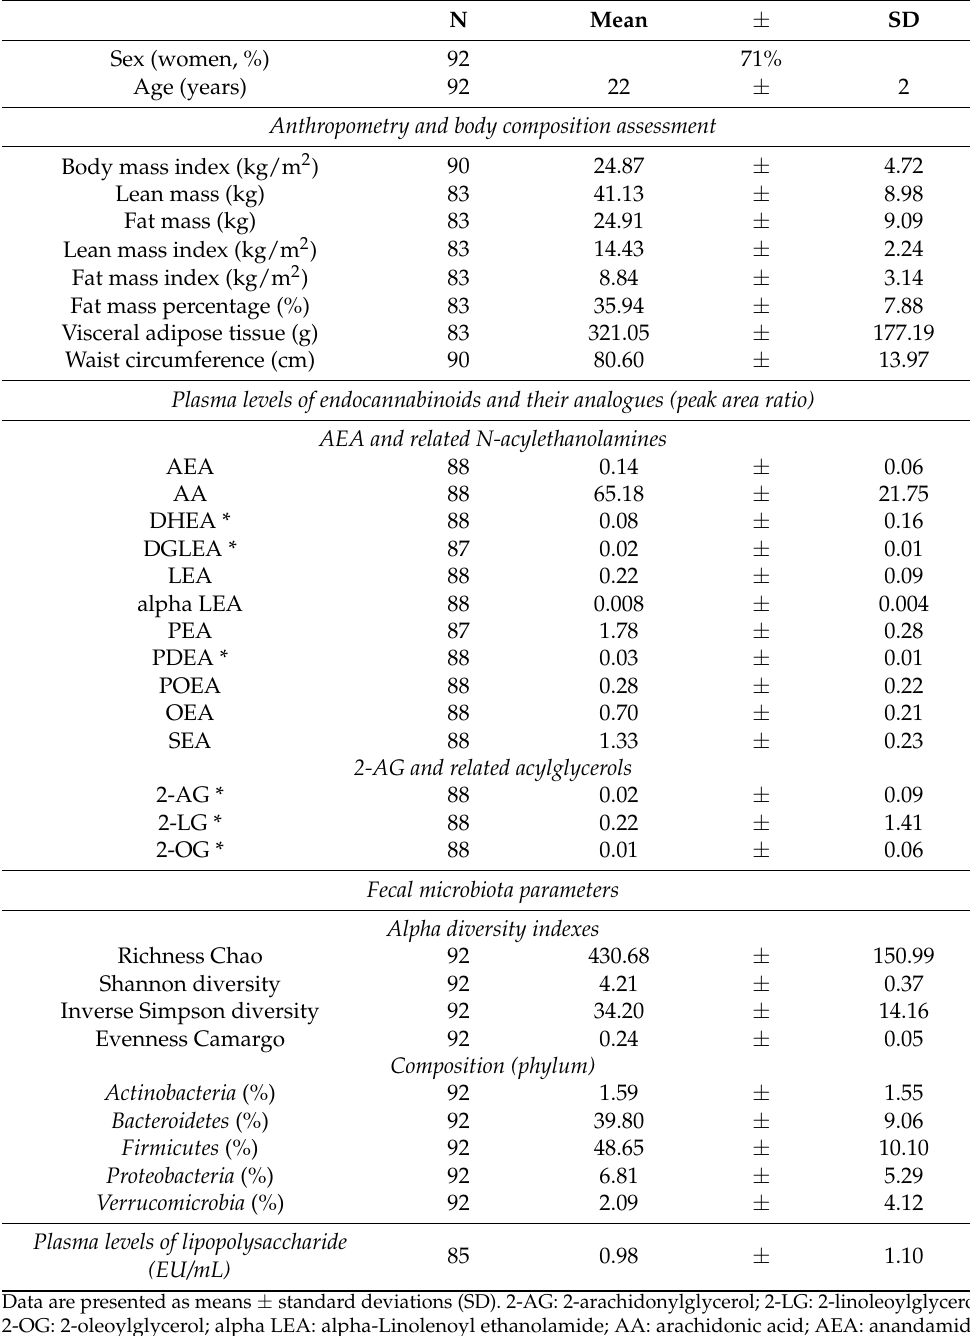
Table 1. Descriptive characteristics of the